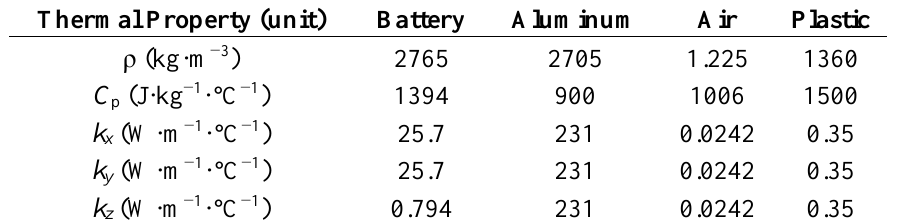
Table 2. Thermal properties of the LIB module compartments used for three-dimensional